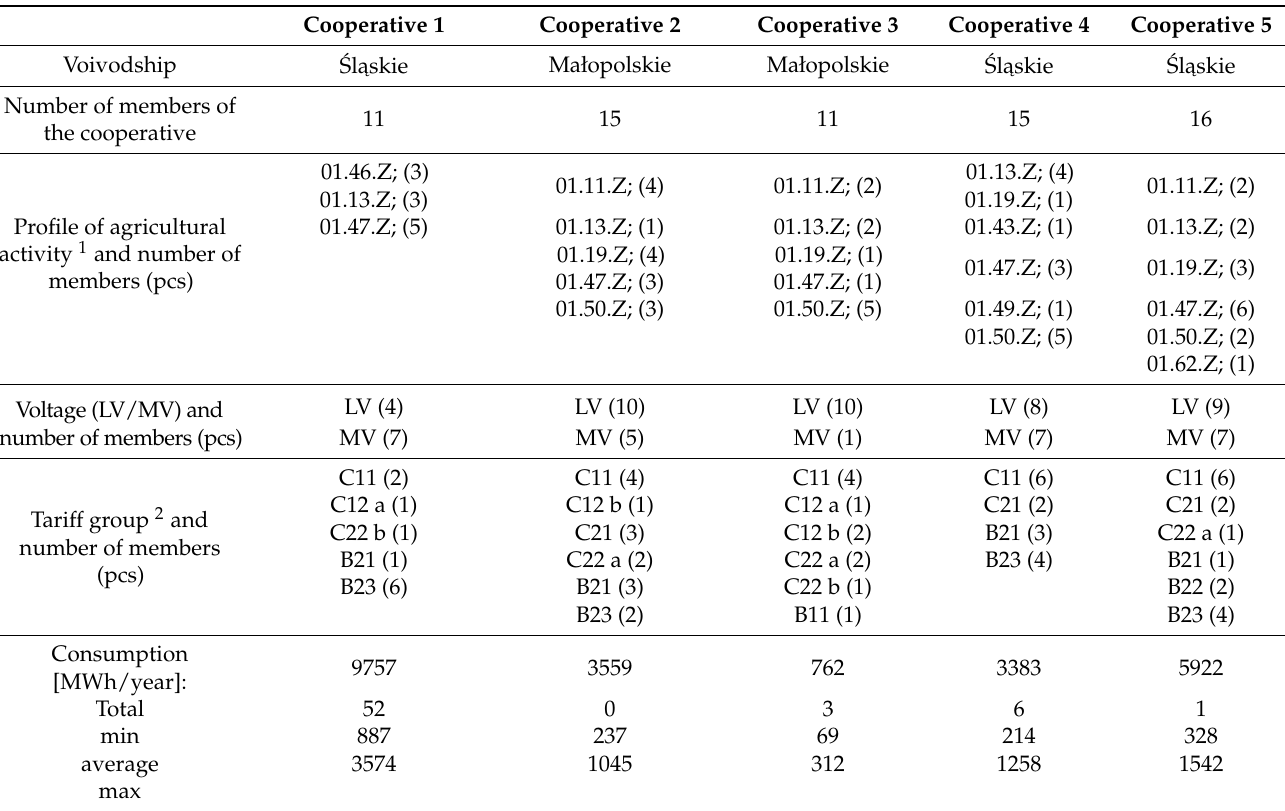
Table 1. Characteristics of each analytical